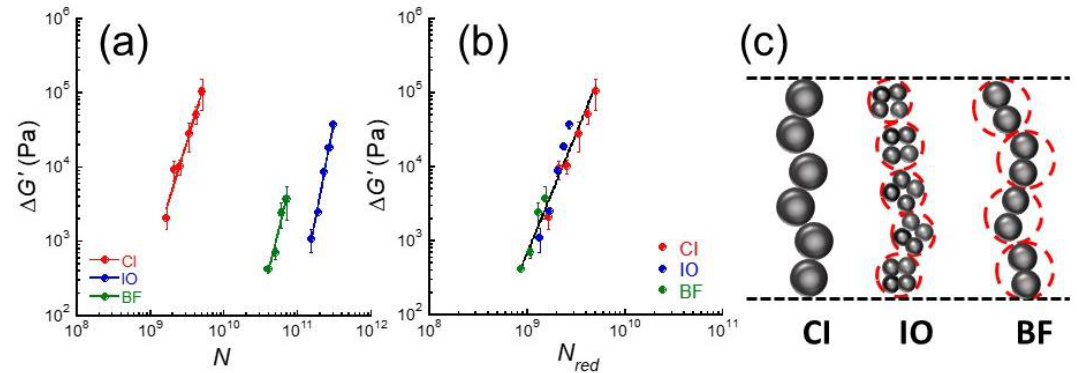
Figure 4. Change in storage modulus due to magnetic fields as a function of ( a ) the number of magnetic particles, ( b ) the reduced number of magnetic particles for carrageenan magnetic hydrogels with carbonyl iron, iron oxide, and barium ferrite particles ( γ = 10 − 4 , f = 1 Hz). ( c ) Schematic illustration for the chain structure of magnetic particles; red circles represent the secondary particles.